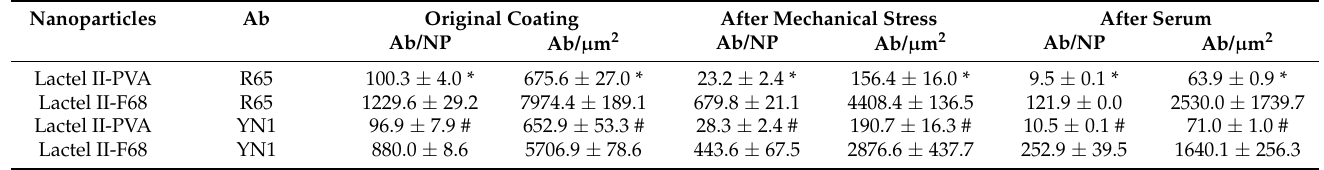
Table 3. Coating of HAse-encapsulated PLGA NPs with targeting antibodies.